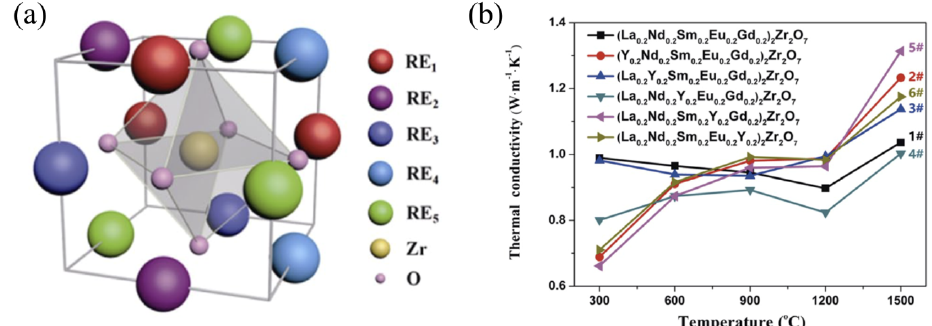
Structure and thermal property of high-entropy rare-earth zirconates: (a) crystal structure and (b) thermal conductivities. Reproduced with permission from Ref. [15], © The Author(s) 2019.